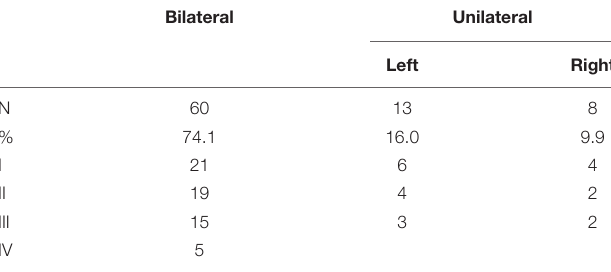
TABLE 2 | Distribution and type of USL involvement in 81 confirmed